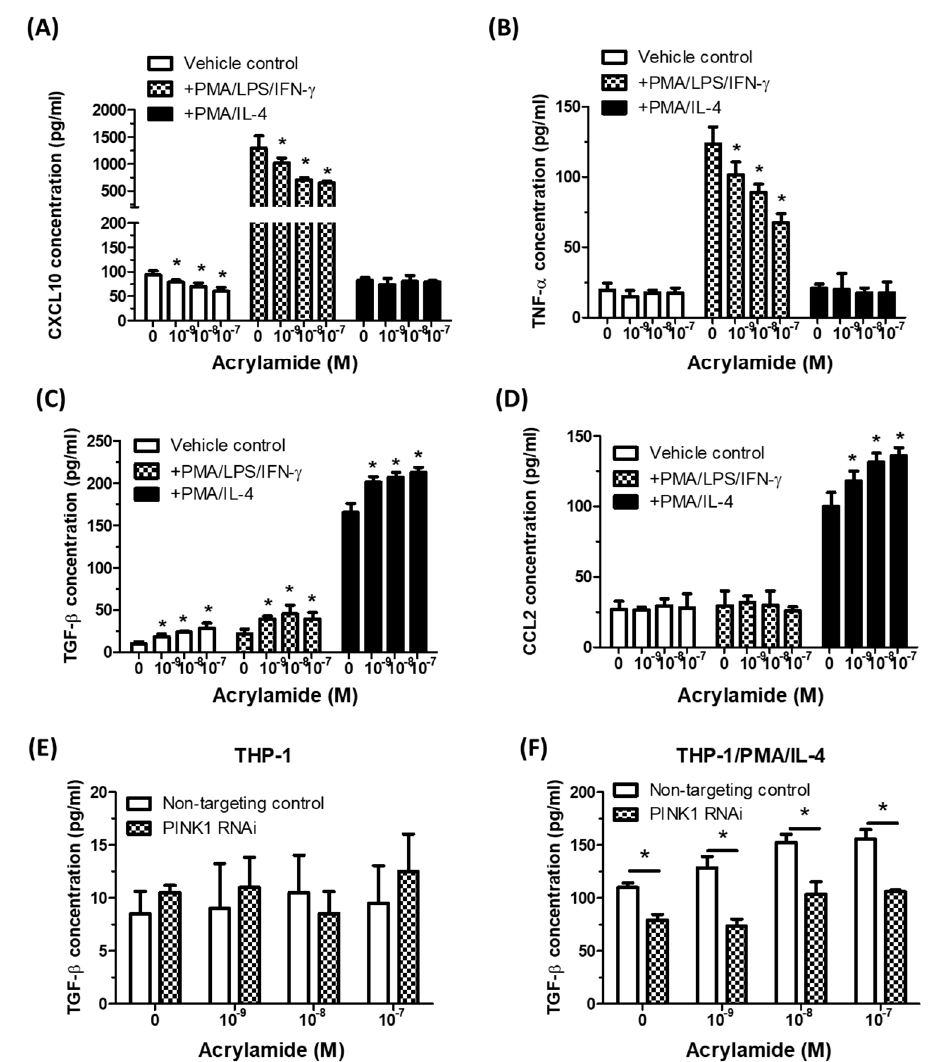
Figure 5. Acrylamide-induced mitophagy was associated with macrophage M2 polarization shift. ( A , B ) The tested THP-1 cells were pretreated with acrylamide and exposed to PMA/LPS/IFN- γ that priming M1 polarization, or exposed to PMA/IL-4 that primed M2 polarization. After 24 h, the cell-free medium were collected and macrophage M1 polarization markers CXCL10 and TNF- α were tested by ELISA. ( C , D ) THP-1 cells were pretreated with acrylamide, with or without PMA/LPS/IFN- γ or PMA/IL-4 treatments. After 24 h, the cell free medium were collected and macrophage M2 polarization markers TGF- β and CCL2 were tested by ELISA. ( E , F ) TGF- β concentrations in THP-1 and PMA/IL-4 primed THP-1 (24 h after acrylamide treatments) with or without PAKIN1 RNAi were detected by ELISA. * p < 0.05, by the Kruskal-Wallis test; n = 3, means ± SD.